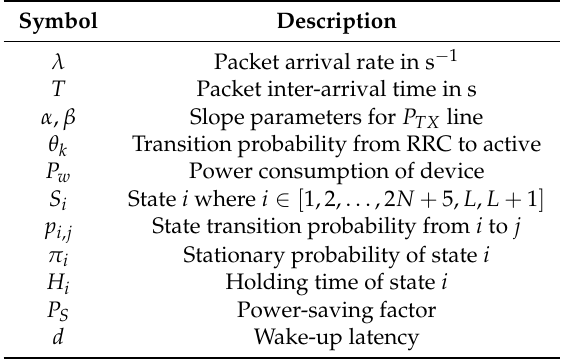
Table 3. List of symbols used for modeling a DRX